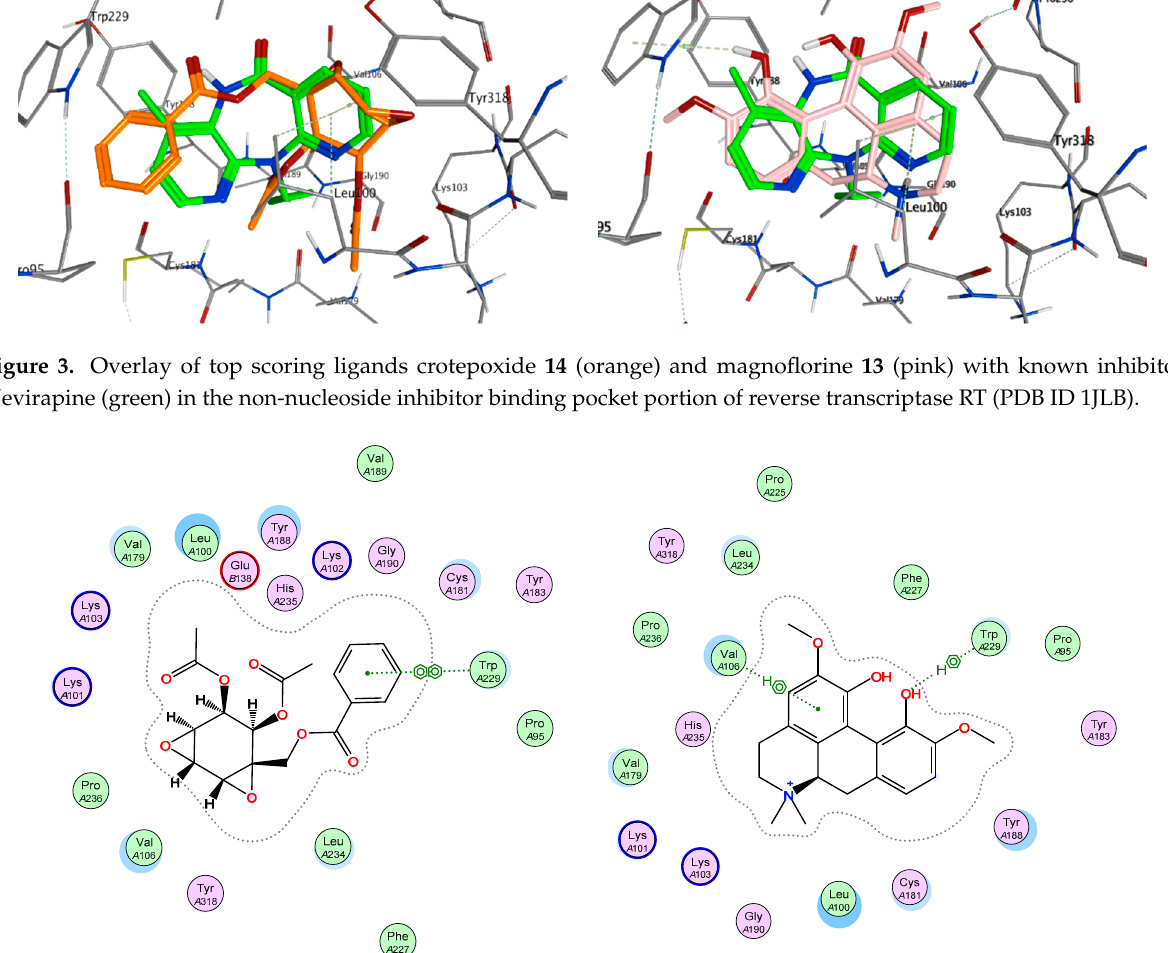
Figure 4. Ligand interactions of top scoring ligands with non-nucleoside inhibitor binding pocket portion of reverse transcriptase RT.